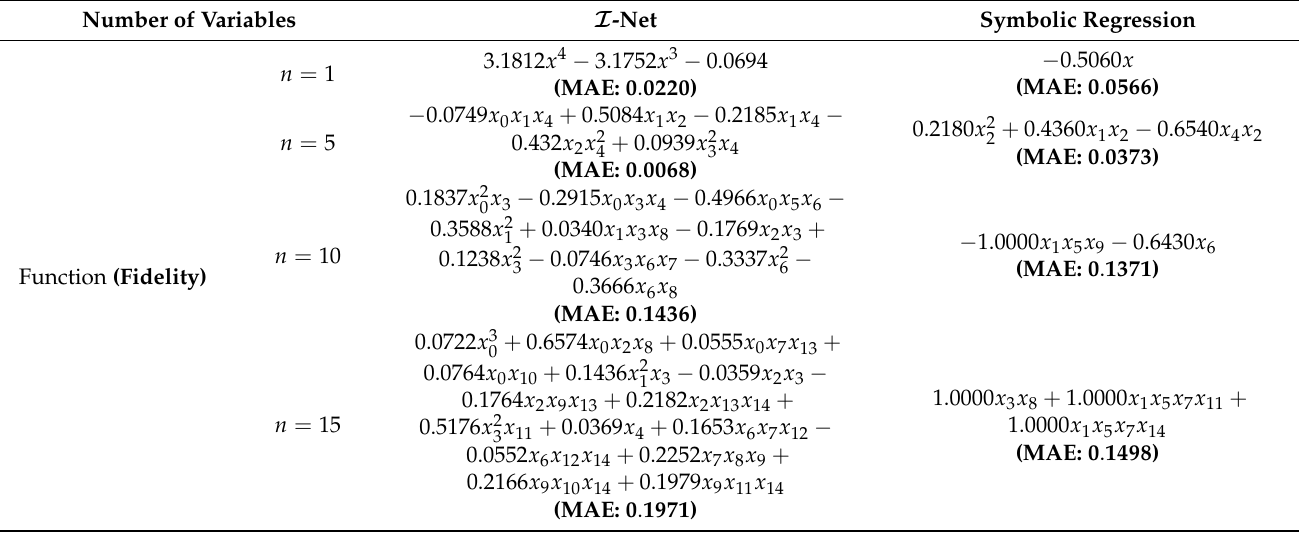
Table 3. Examples of generated